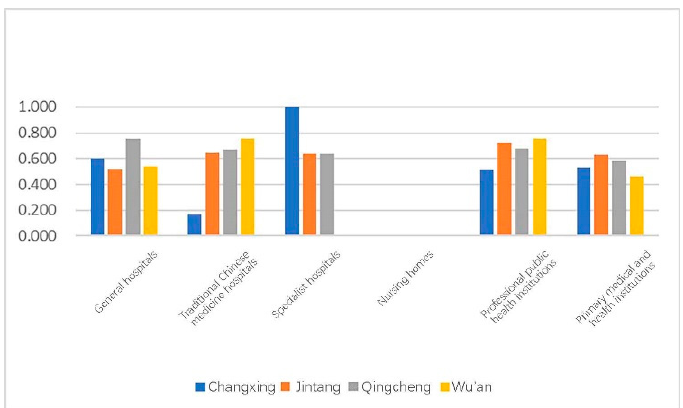
Figure 8. Graph of the average value of the comprehensive urban land accessibility of the locations of medical facilities at all levels in a typical county.